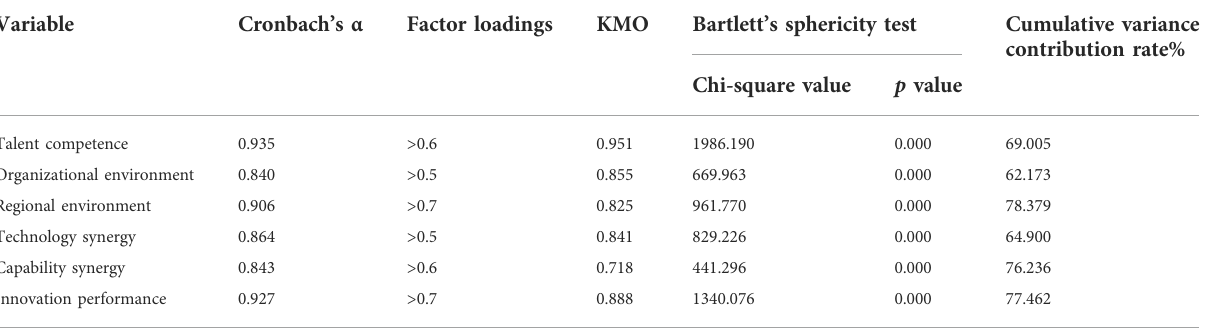
Technology synergy